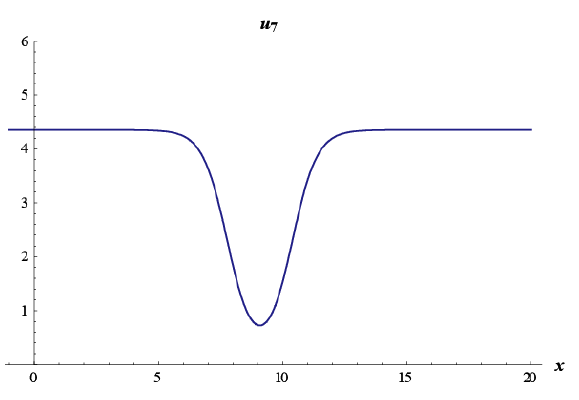
Figure 9. Two-dimensional surface of